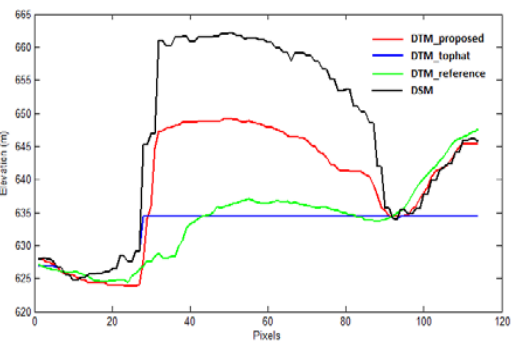
Figure 7. Profile comparison between the DTMs along the red line in Figure 5a (Black: original DSM; Red: generated DSM; Blue: tophat morphological reconstruction; Green: reference